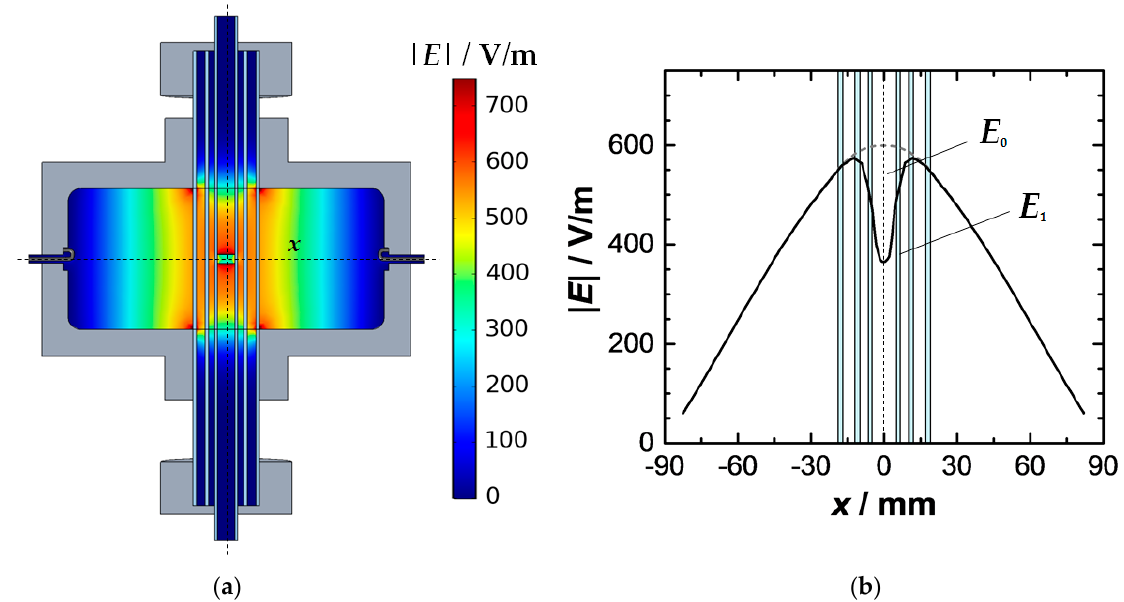
Figure 4. Depolarization of a ceria powder ( ε r,e ff (cid:48) = 2.59) in the excitation field of the resonator: ( a ) electric field distribution (sectional view) in the resonator and within the sample; ( b ) electric field along the x -axis with pronounced weakening at the location of the sample ( x = 0).